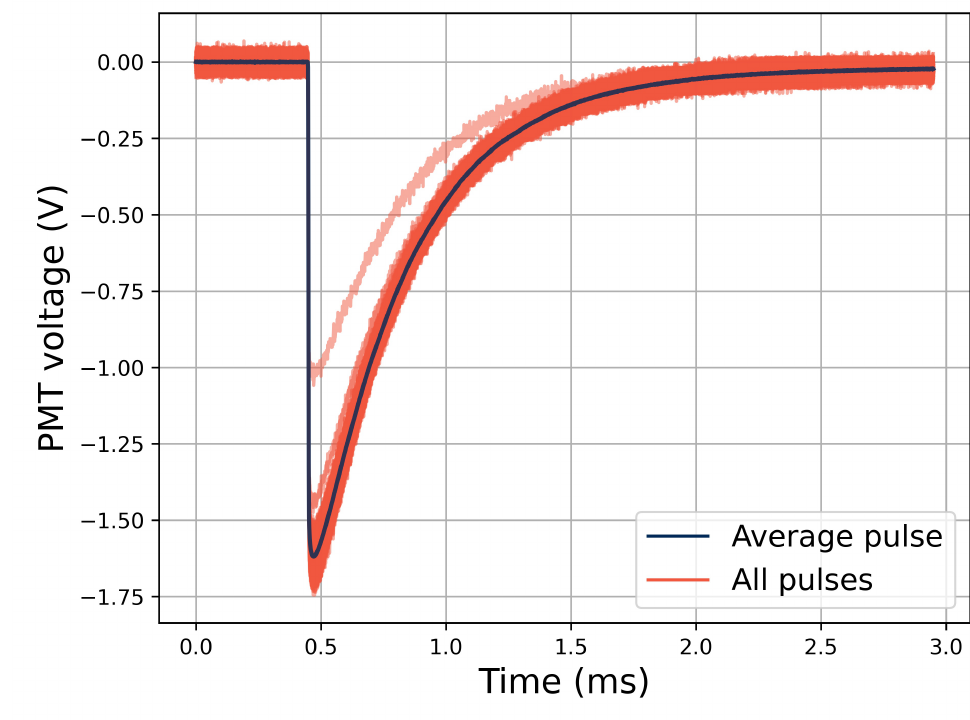
Figure 6. Collected pulses in the oscilloscope from 20-Hz electron bunch irradiation of the Ce-doped rod sample at 9.7 × 10 − 4 Gy/bunch.